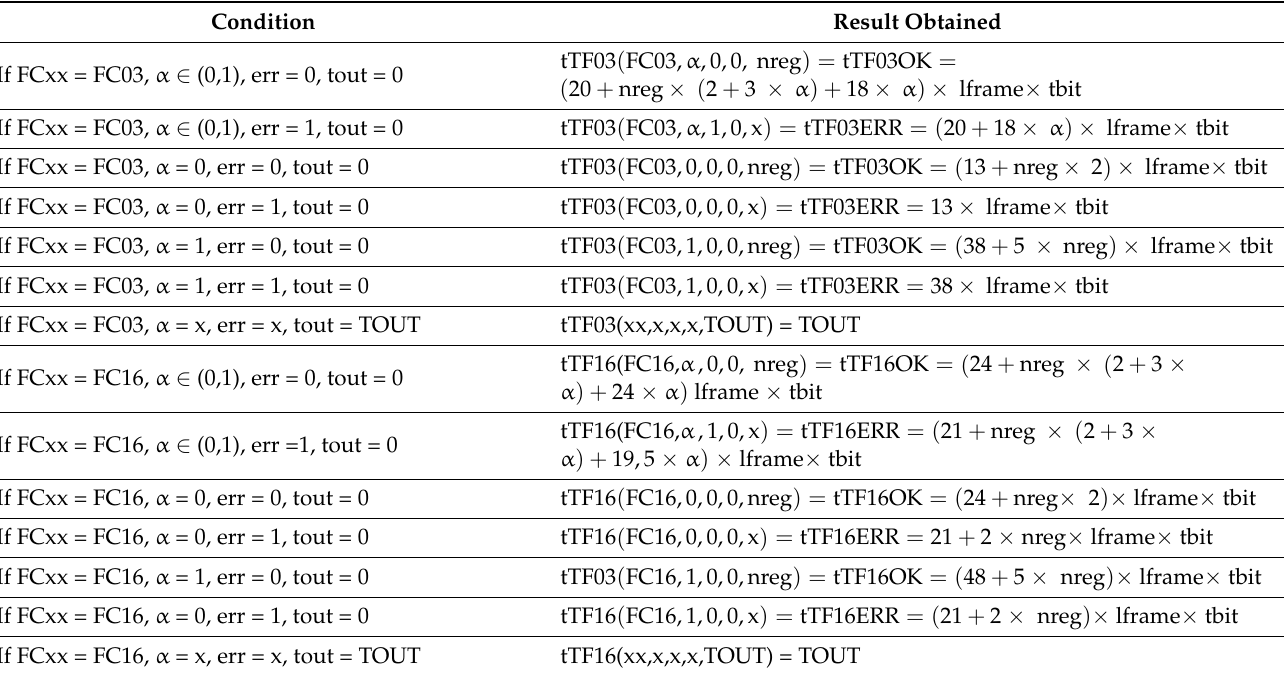
Figure 5. Modbus protocol experimental tests: ( a ) server query message timing with ID 0x01 and function FC03; ( b ) time required for processing at server with ID = 0x01 and FC03 (analysis of re- quest and sending response; forced delay = 1 ms); ( c ) time required for response message of server with ID 0x01 and function FC03. Table 2. Modbus transaction-timing-based tTFxx (FCxx, α , err, tout, and nreg) function.